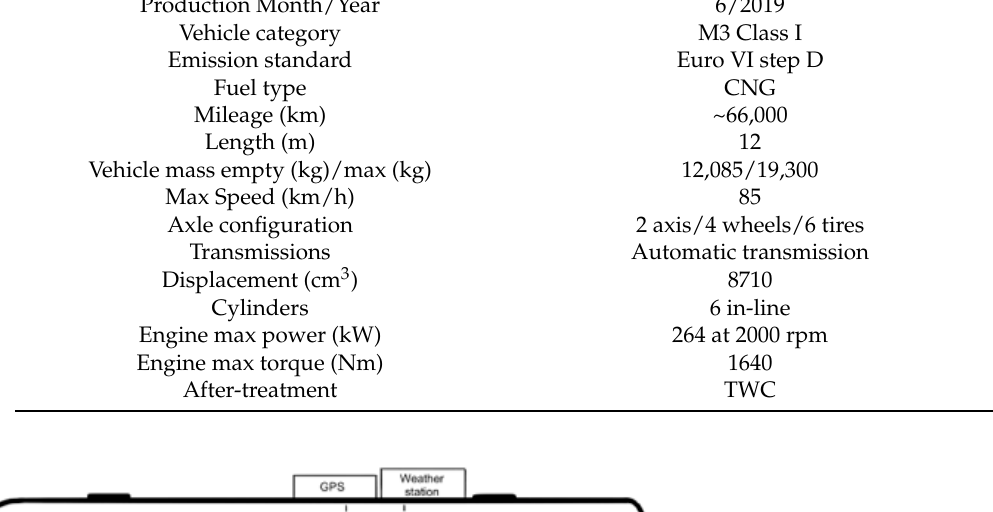
Table 1. Vehicle specifications. Table 2. Route characteristics.